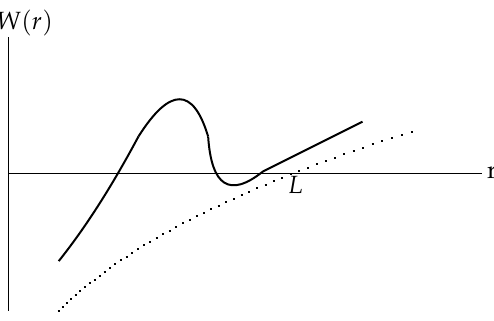
Figure 1. The function W(r) for a tachyon: two